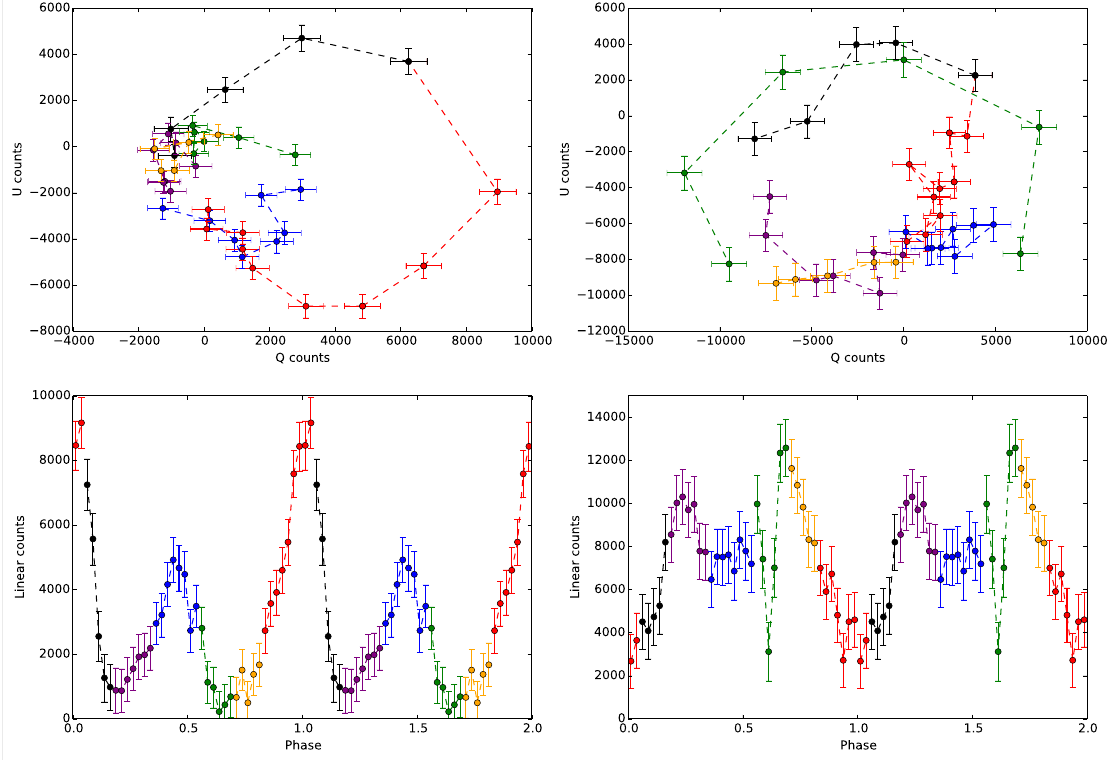
Figure 2. Spin phased variation of the Stokes Q and U parameters ( upper panels ) and total linearly polarized flux ( lower panels ) for the red-band (570 − 900nm) on the two nights 14 ( left ) and 15 ( right ) March 2016. The migration of the Stokes Q and U amplitude pairs are shown, plotted every 3 s, with 40 points plotted per spin cycle. Points are colour-coded as in the average phase-folded linearly polarized flux plots. The Q , U pairs follow counter-clockwise